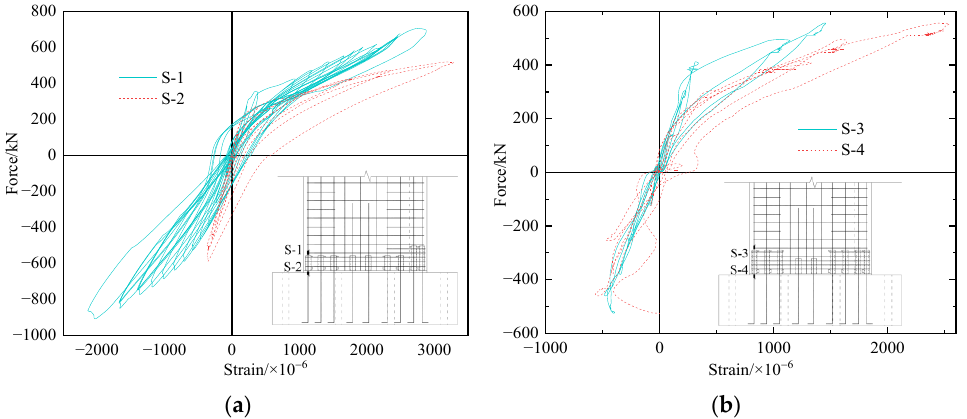
Figure 14. Force – strain curves of the outermost longitudinal rebars of the straight-edge member at 10 mm above the base beam and sleeves of LAPC-1 and LAPC-2: ( a ) LAPC-1; and ( b ) LAPC-2. Figure 15 shows the strain distribution of longitudinal rebar along the long leg of the prefabricated walls at 10 mm above the base beam and sleeves (the coordinate at the center of the long leg is 0). Due to the failure of some strain-measuring points in the loading process, the strain values of some positions of rebars were not obtained. It was found that the strain of longitudinal rebars at the same section of the prefabricated walls was basi- cally linearly distributed, i.e., the specimens basically satisfied the assumption of plane section before yielding, and with the increase of load, the strain value of the rebar at each position increased continuously, which indicated that the APC connectors effectively transferred the stress of rebars. In addition, the strain variation of rebars in the straight- edge member (i.e., the position is from −700 mm to −300 mm) was larger than that of the L-shaped-edge member (i.e., the position is from 200 mm to 700 mm), which was mainly due to fewer rebars and less concrete in the straight-edge member.